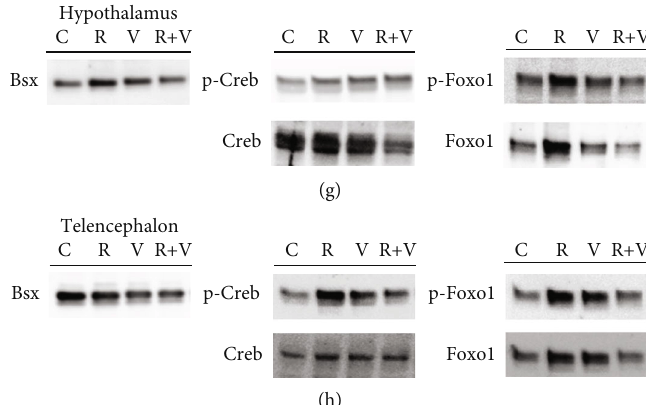
Figure 3: Abundance of Bsx (a, b) and phosphorylation status of Creb (c, d) and Foxo1 (e, f) in hypothalamus (a, c, e) and telencephalon (b, d, f) of rainbow trout 6h after intracerebroventricular injection of 1 μ L · 100g -1 body mass of a solution containing saline and dimethyl sulfoxide (DMSO) alone (control) or containing 20mM rapamycin (R), 80mM of L-valine (V), or rapamycin with valine (R+V). Values are mean + SEM of N = 6 fi sh per treatment. One representative blot per treatment is shown for the hypothalamus (g) and telencephalon (h). Signi fi cant di ff erences ( P < 0 : 05 ) among groups are denoted with di ff erent